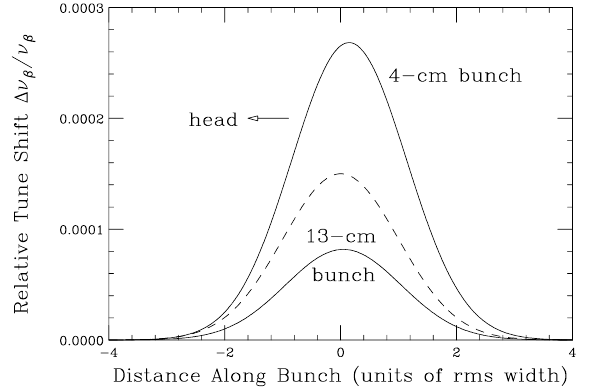
FIG. 19. Relative tune shift compensation for beam particles at distance z (cid:1) s (cid:1) behind the bunch center (or bunch going to the left) to cure beam breakup for the 4-cm and 13-cm bunches. The bunch profile is plotted in dashes as a reference.